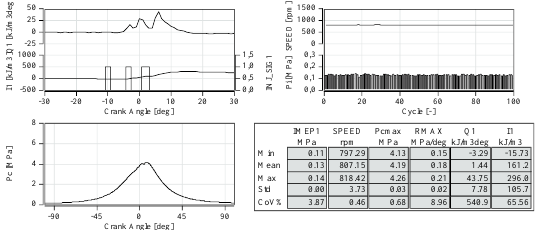
Fig. 6. Engine idle running with diesel supply; The courses of developing heat (Q1) and amount of developed heat (I1), mean indexed pressu- -re (IMEP1) are